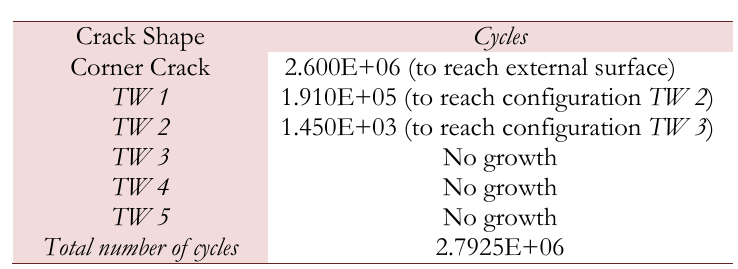
Table 9: Number of cycles for different crack configurations.